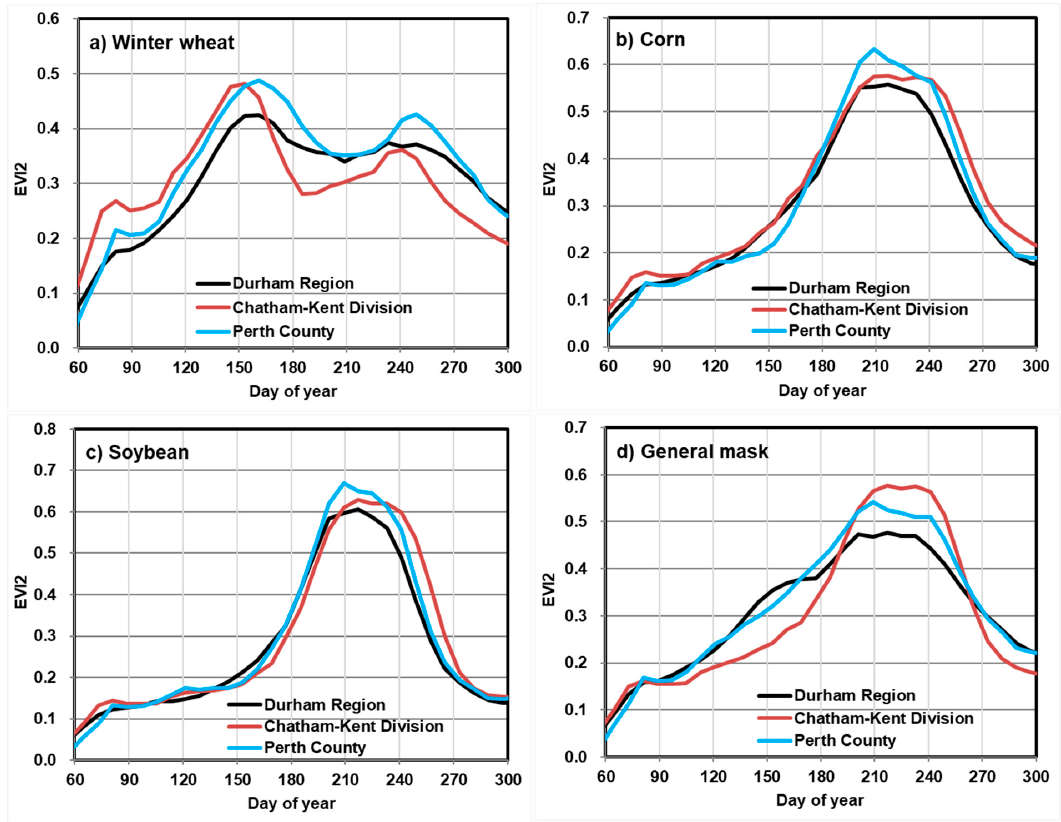
Figure 3. Crop growth profiles from March to October, illustrated using two-band enhanced vegetation index (EVI2) extracted for winter wheat ( a ), corn ( b ), soybean ( c ), and the three crops combined ( d ). The curves were derived from 2016 for three representative counties in Southern (Chathem-Kent), Western (Perth), and Central (Durham) Ontario (refer to Figure